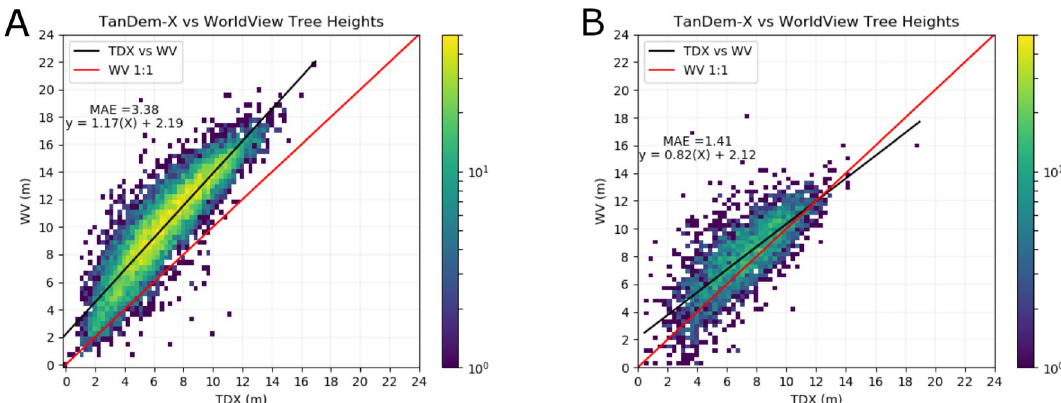
Figure 6. Calibration and Validation of the TanDEM-X derived canopy height estimate, with reference to WorldView Stereo Imagery. ( A ) The calibration of the canopy height map. ( B ) A correction from ( A ) was applied and the canopy height was compared to an independent WorldView Stereo